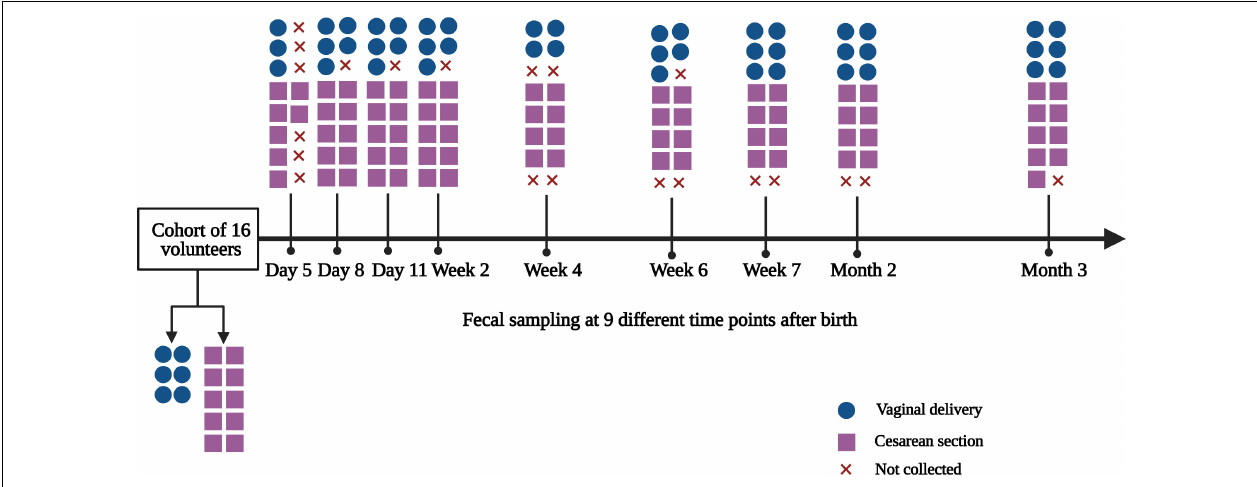
FIGURE 1 | Flow diagram of the study. The diagram showed the fecal samples collected at 9 time points. x, fecal samples were not collected by parents as the infants had no defecation.